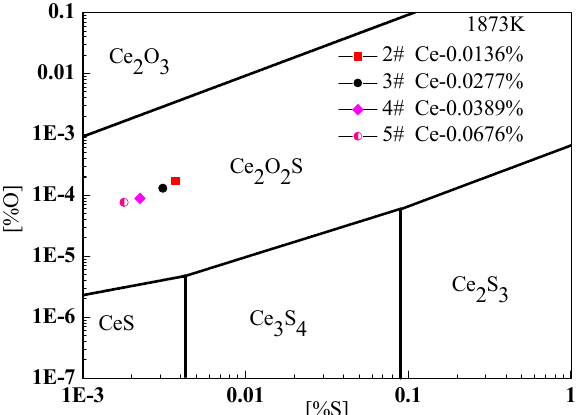
Figure 3. Data points of the 2 # ~5 # heats in a phase stability diagram of the inclusions bearing cerium. Table 5. The composition and morphology of typical inclusions in the 1 # ~5 # steel.